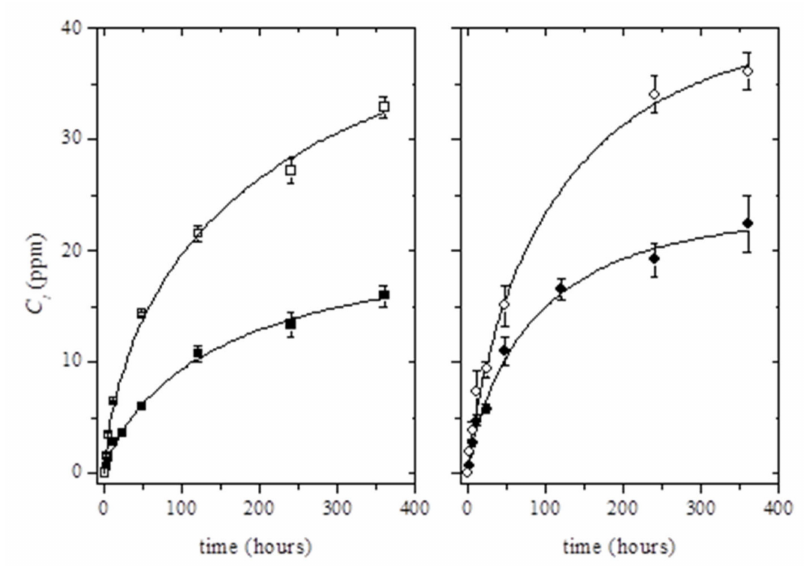
Figure 3. Release kinetics of thymol from binary systems (black dots) and ternary systems (white dots) at 6 wt% ( left ) and 8 wt% ( right ) at 40 ◦ C. Solid lines were obtained by fitting Equation (2) to the experimental data points.